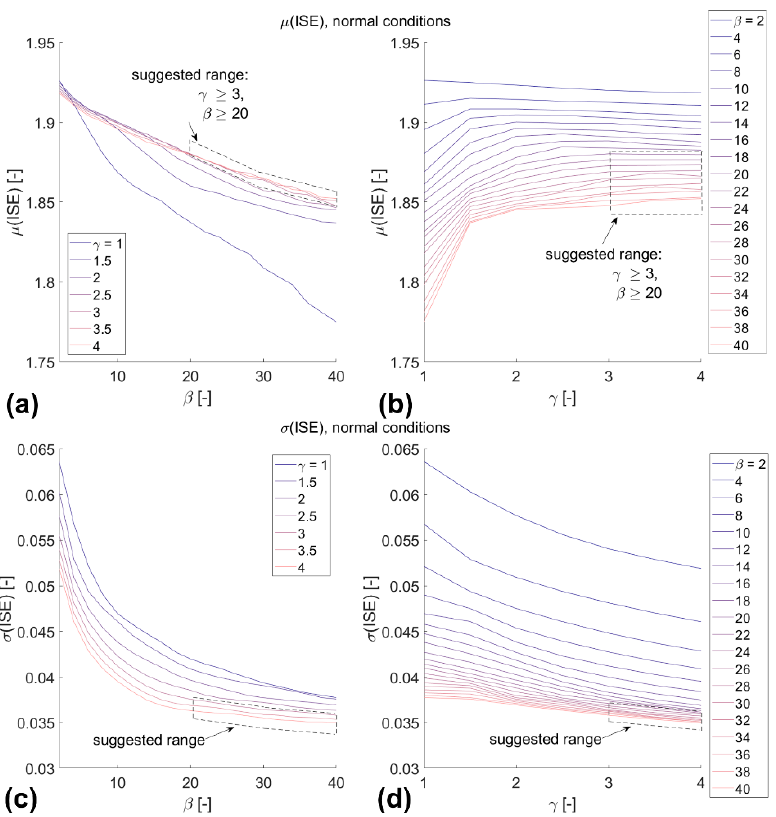
Figure 11. Trends of ISE values for the normal conditions. ( a ): 𝜇(ISE) for varying 𝛽 ; ( b ): 𝜇(ISE) for varying 𝛾 ; ( c ): 𝜎(ISE) for varying 𝛽 ; ( d ): 𝜎(ISE) for varying 𝛾 .